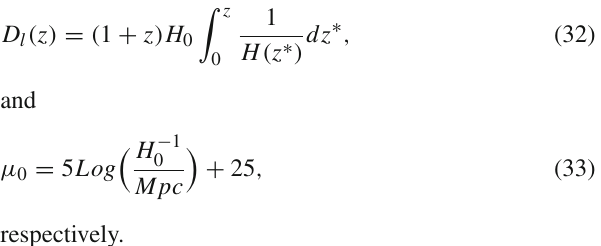
Fig. 1 Figures ( a ) and ( b ) represent the comparison of our model and (cid:5) CDM model with blue color error bars of observational H ( z ) 29 data points and SNeIa Union 2.1 compilation data points respectively. Red lines indicate our model and black lines indicate the (cid:5) CDM model in both plots. We observe that our model fits well with both observational data points especially at z <